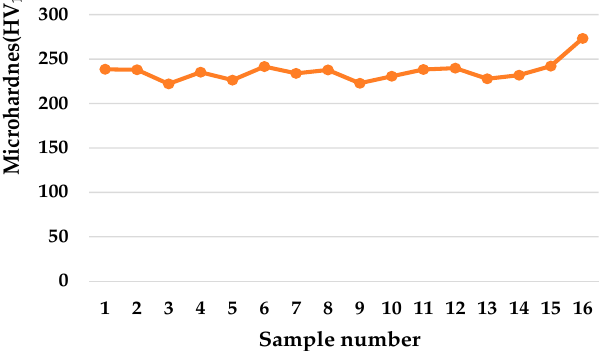
Figure 7. Result of microhardness test for the deposited blocks.